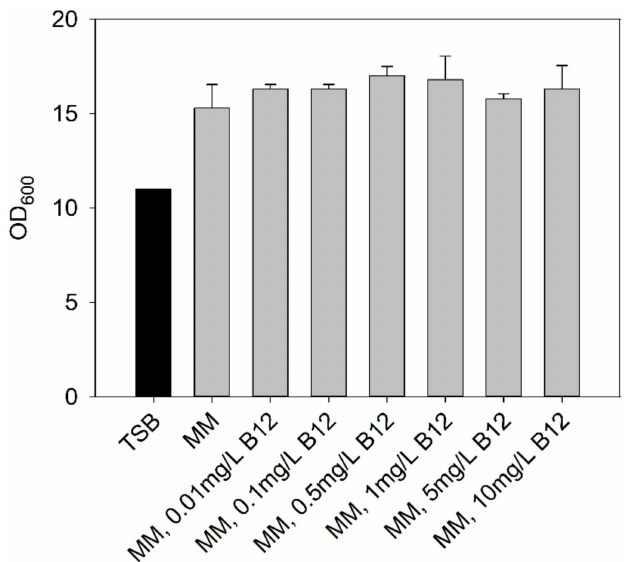
Figure 4. OD 600 values of C. necator cultures in MM supplemented with B12. Black bar refers to cultures in TSB. (2 days of cultivation at 30 ◦